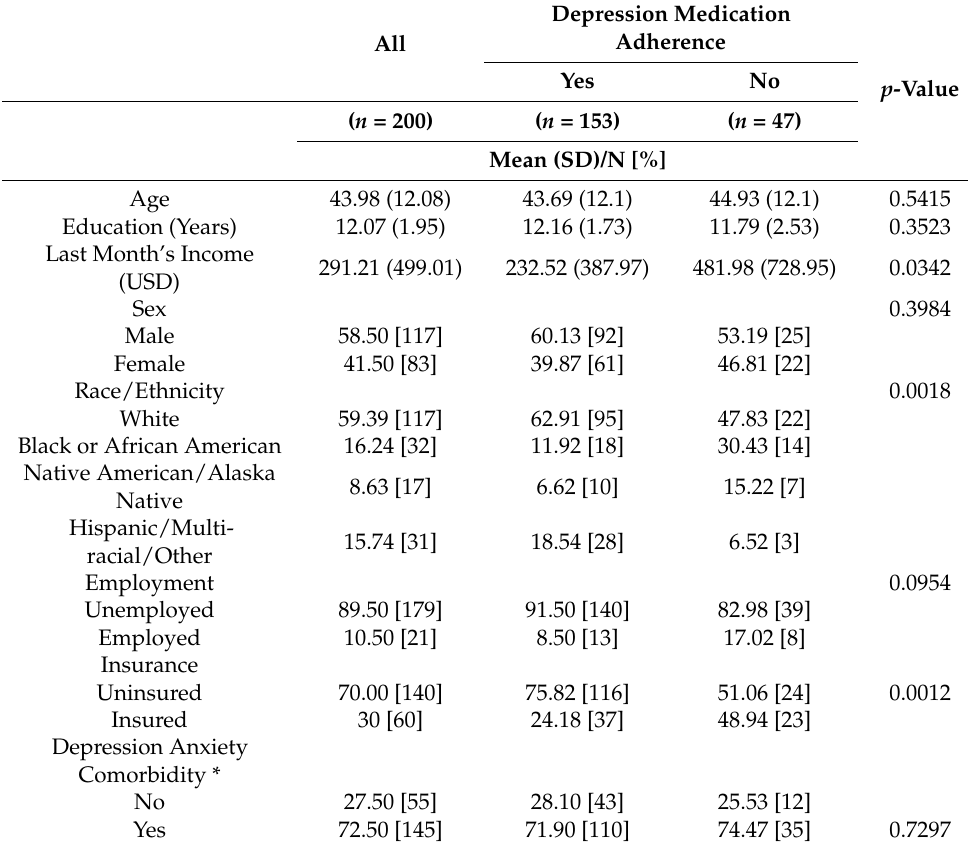
Table 1. Participant Demographics by Depression Medication Adherence Status.